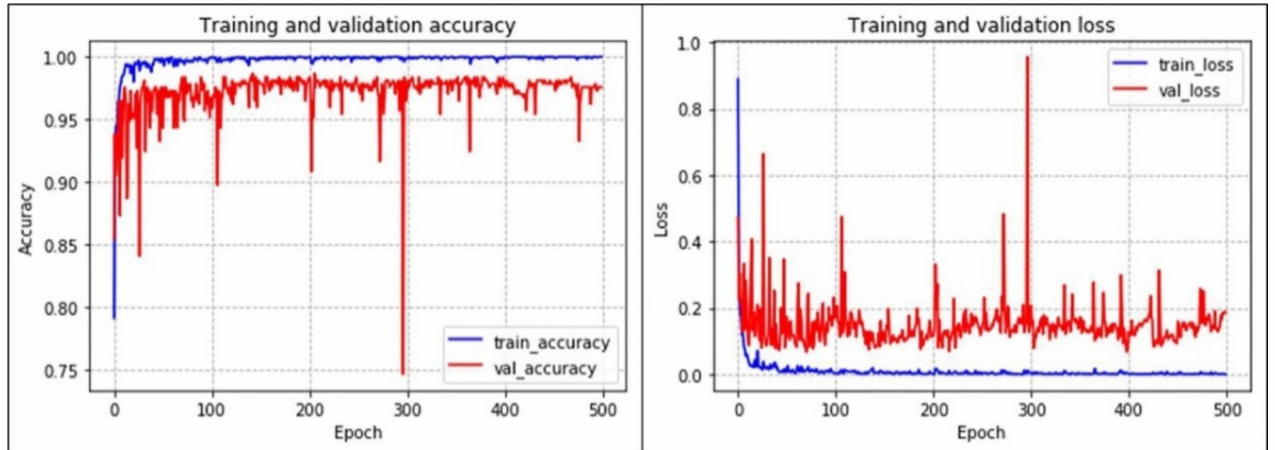
Figure 12. The accuracy and loss error of the baseline VGG19